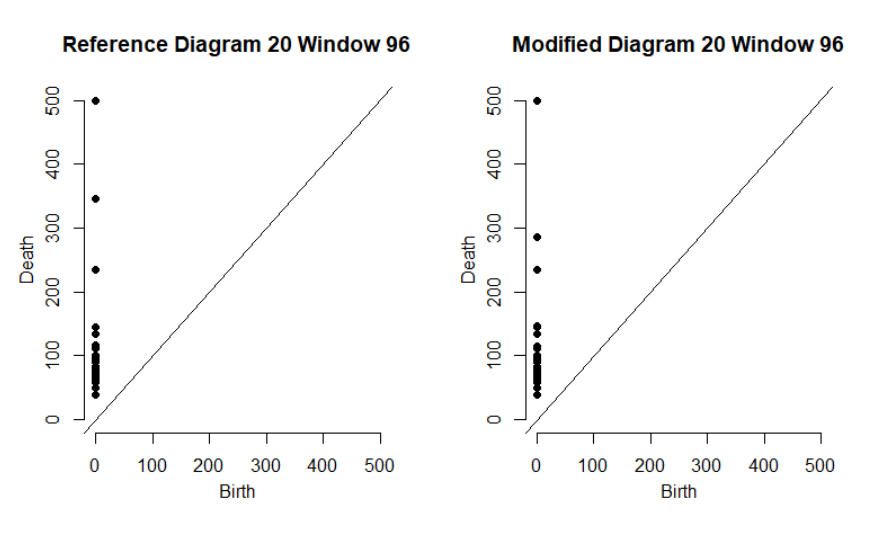
Figure 3. A plot of the persistence diagram for 20th reference diagram (left) and the modified persistence diagram (right) when week 6 replaces one of the randomly chosen observations in the 7th reference bag. This corresponds to the traffic behavior at sensor S 314402 on Monday, 6 February 2017 from 7:55–8:55